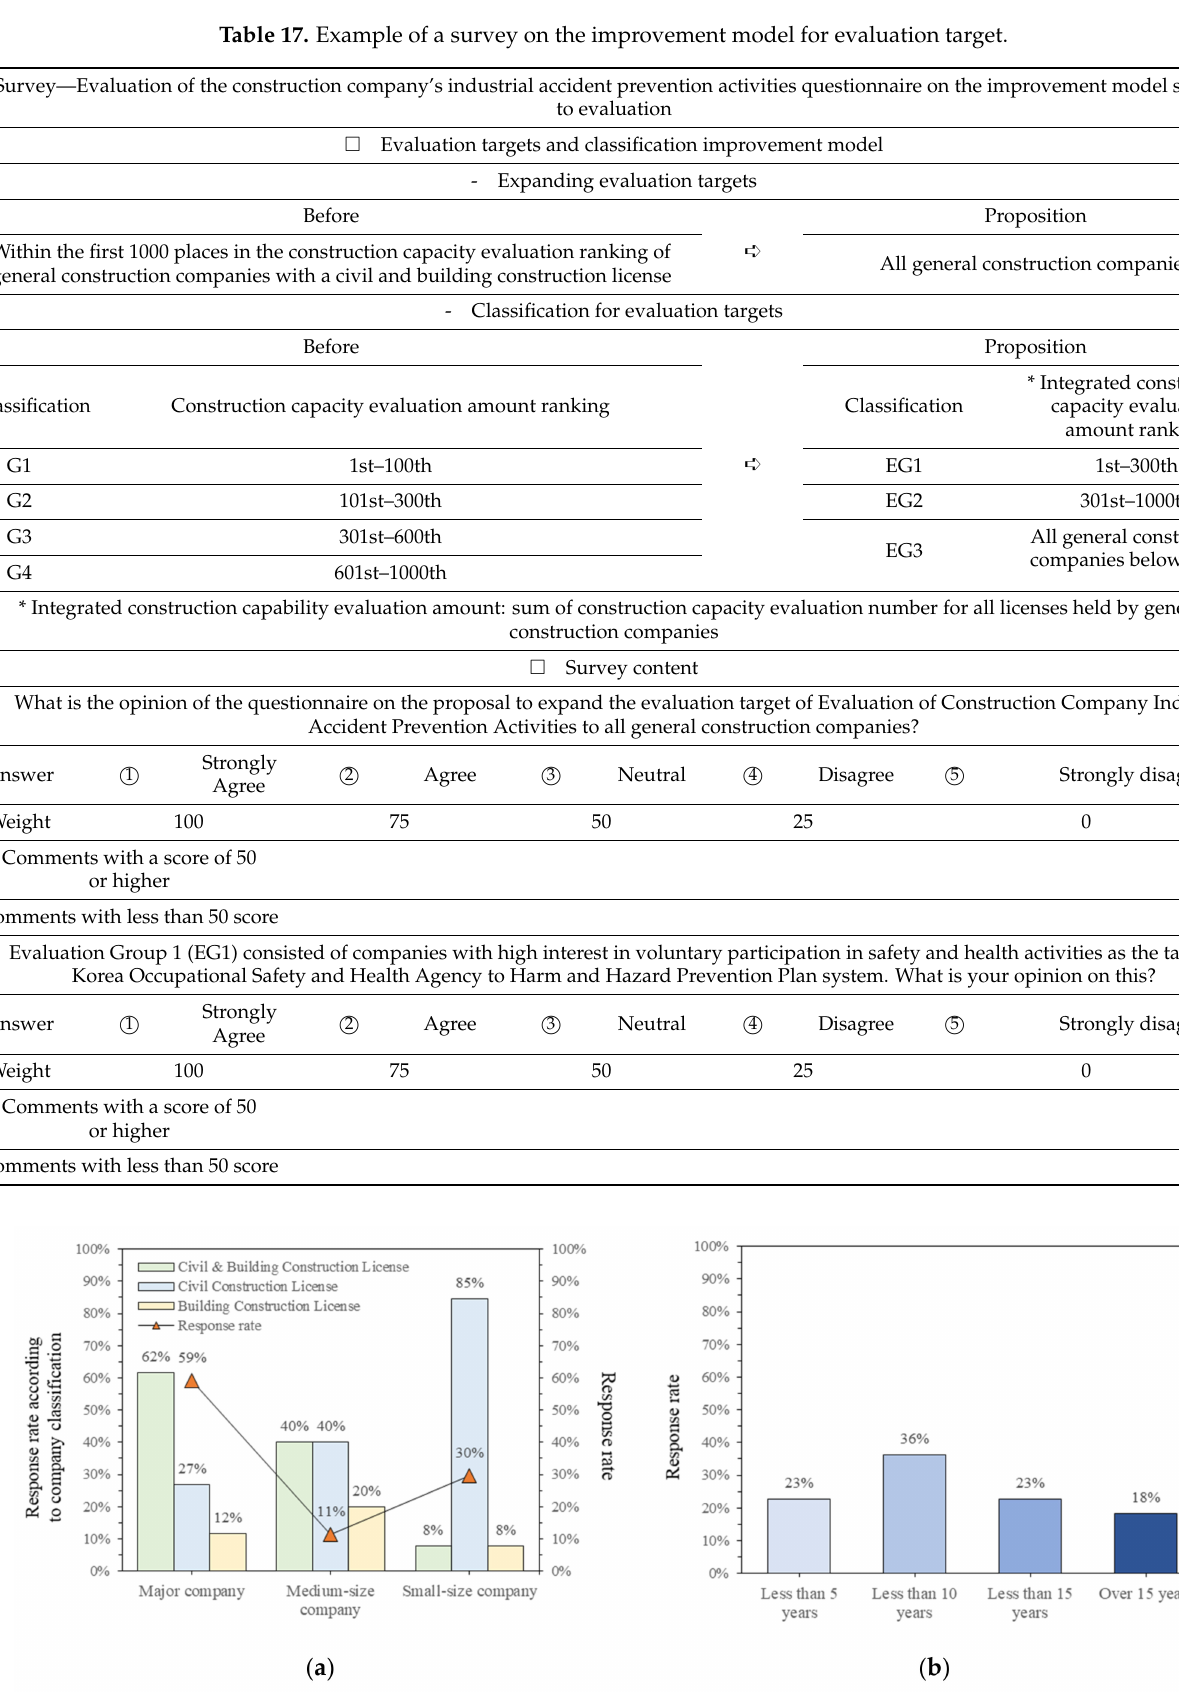
Figure 8. Surveyor’s basic information: ( a ) classification and license of surveyor’s company; ( b ) surveyor’s career